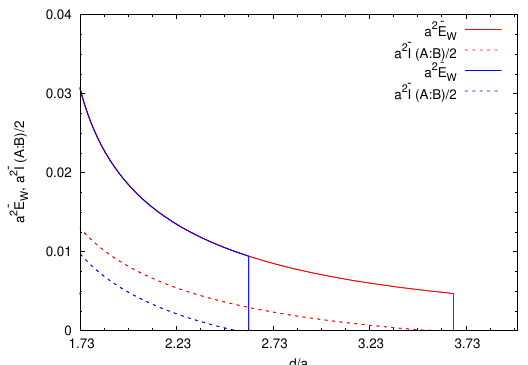
Figure 9 . Effect of UV/IR mixing on EWCS and HMI at finite temperature aT = 0 . 1 above plot, the red curves (both solid and dotted) correspond to au b = 10 and the blue curves (both solid and dotted) correspond to au b = 20 . We have set l